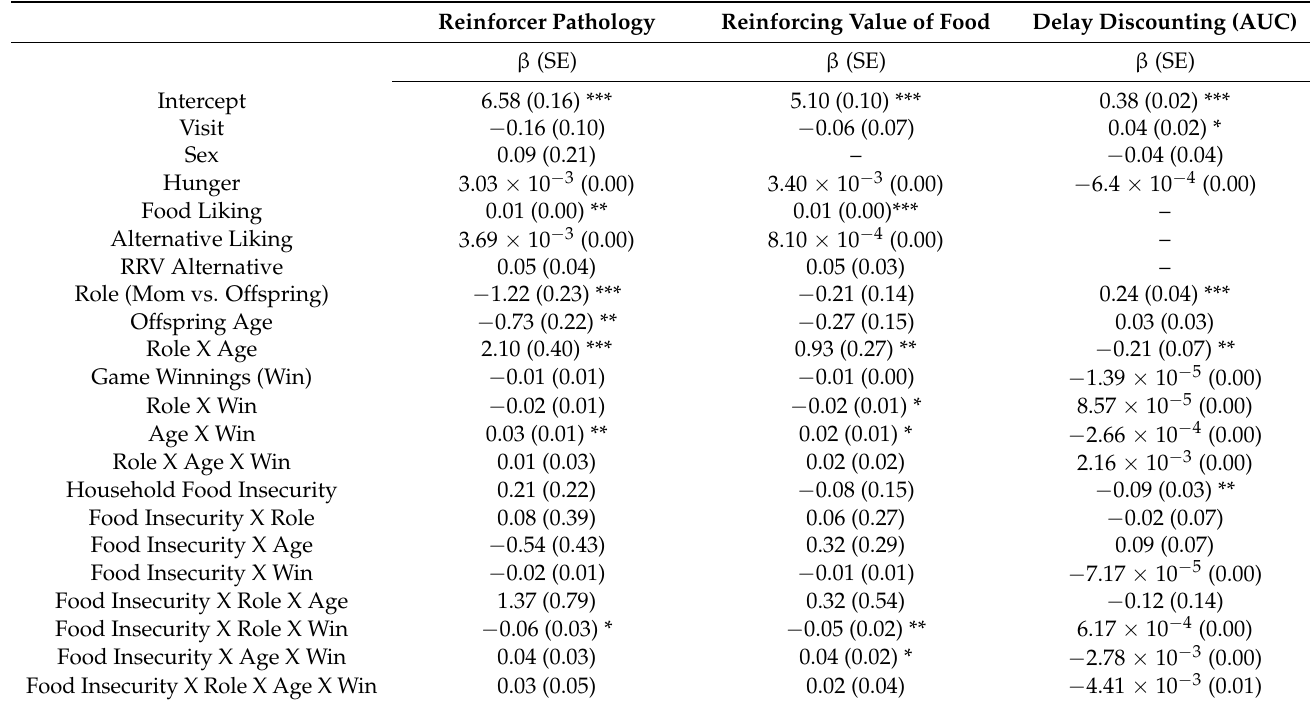
Table 3. Effects of Financial Losses on Reinforcer Pathology across Families and Food Insecurity Status. Reinforcer